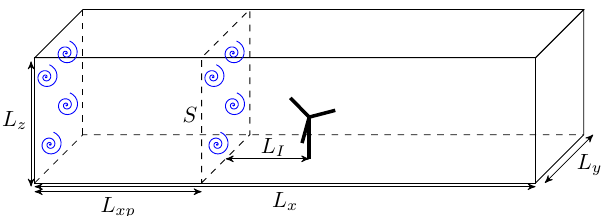
Figure 2. Domain of the main simulations. L xp is the length of the prerun domain. The turbulence at the recycling surface S is used as input at the inflow again. L I is the distance from the recycling surface to the wind